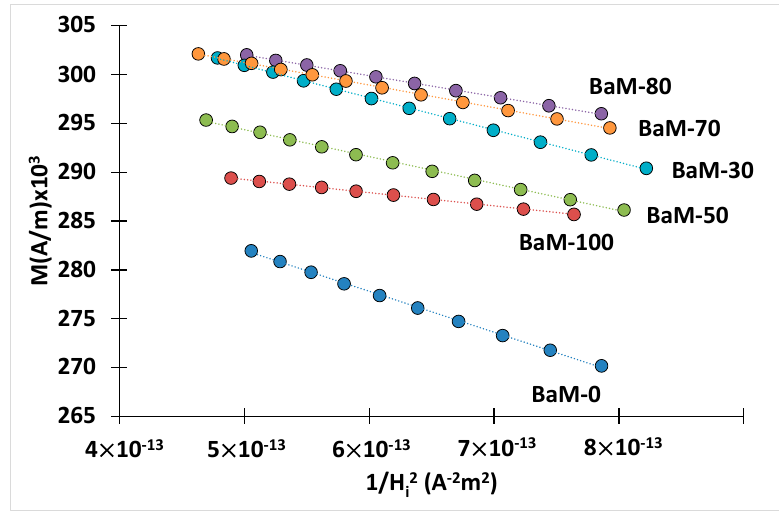
Figure 12 . Law of approach to saturation of some BaM samples. The determination coefficients R2 in M vs. 1/Hi2 linear relations are better than 0.999 in any case. Table 4. Data obtained from hysteresis loops and the law of approach to saturation. M S is the saturation magnetization, M R // and M R ⊥ the remanent magnetizations measured along the easy axis and perpendicular to the easy axis, respectively. α 50 is the full width at half remanence measured in ARM. For A uni ( K 1 , ρ ), see Equation (12) and main text.